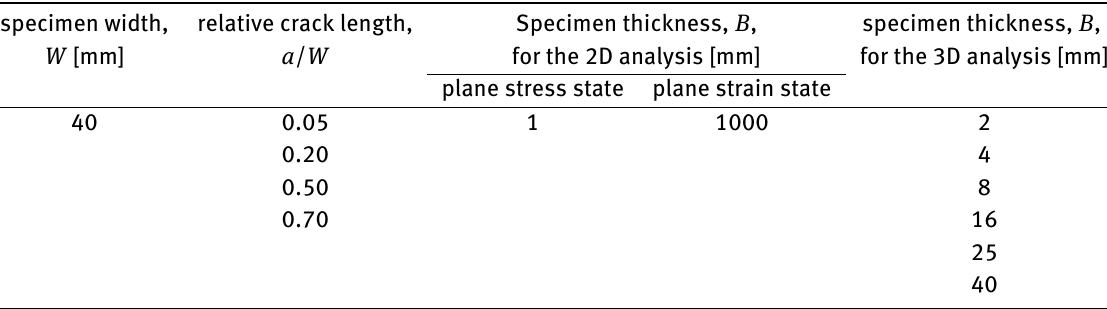
Table 1: Geometric dimensions (with configurations) of the specimens used in the numerical program to calculate the limit loads for CCSP(BT) [12].